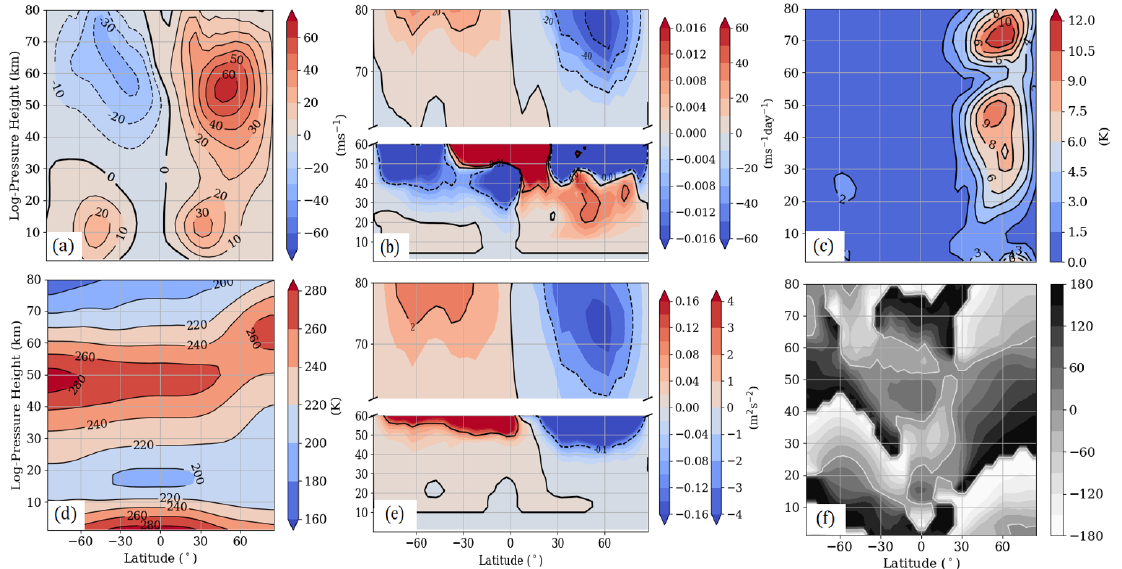
Figure 1. Zonal mean monthly mean ( a ) zonal wind (ms − 1 ), ( b ) gravity wave (GW) zonal wind acceleration (ms − 1 day − 1 ) with two different scalings (left color bar-up to 60km, right color bar-above 60km), ( c ) SPW 1 amplitude (K), ( d ) temperature (K), ( e ) zonal GW flux (m 2 s − 2 ) with two different scalings (left color bar-up to 60km, right color bar-above 60km) and ( f ) stationary planetary wave (SPW) 1 phase ( ◦ ). Results refer to January conditions, and to the reference (Ref)